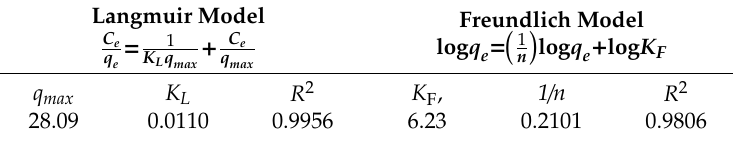
Figure 9. Freundlich isotherm plot of Cd 2 + adsorption on FA / H 2 SO 4 . Table 3. Adsorption isotherm parameters of Cd 2 + onto FA / H 2 SO 4